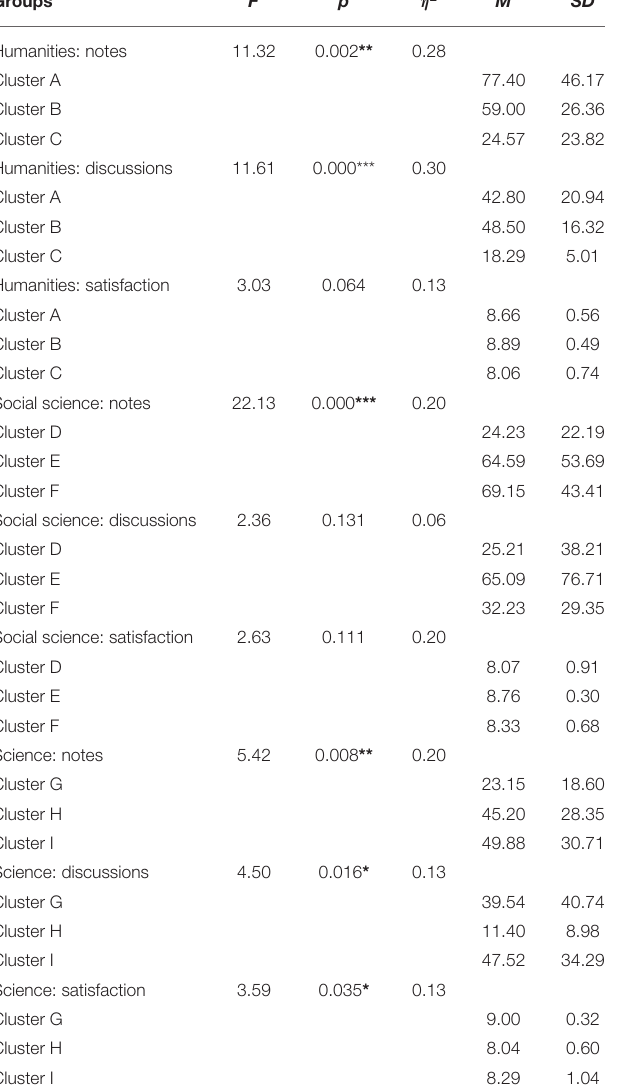
TABLE 2 | The results of multiple comparisons by using TukeyHSD test. Comparisons Mean